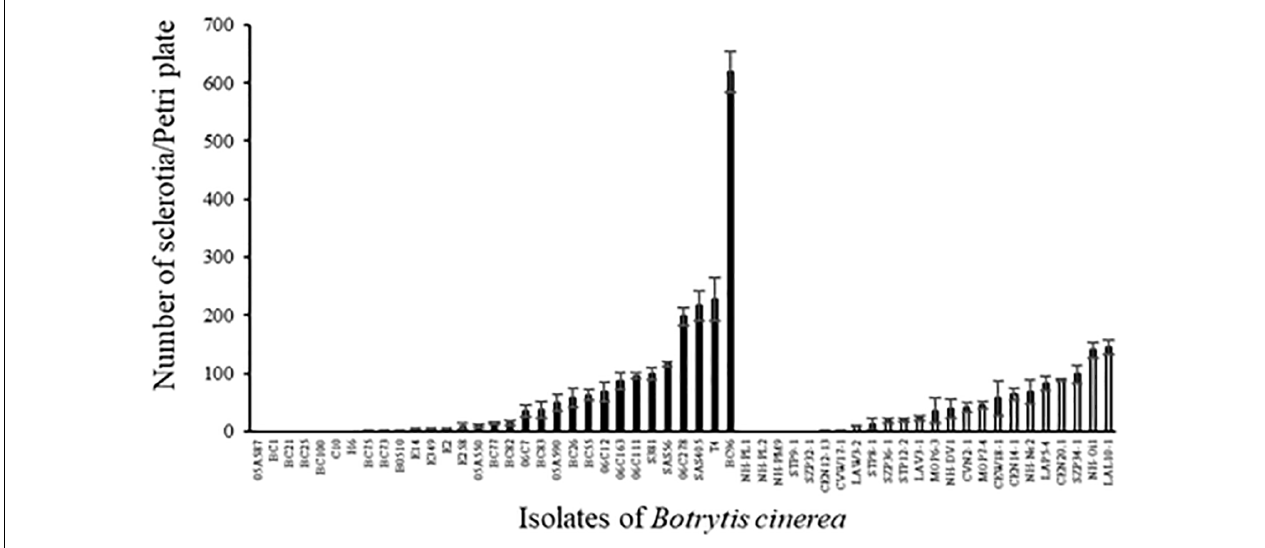
FIGURE 5 | Number of sclerotia produced by 31 agricultural (black) and 24 environmental (white) strains of B. cinerea on PDA medium after 5 weeks of incubation in controlled condition at 21 ◦ C (1 week with a photoperiod of 14 h at 114 µ mol m − 2 s − 1 and 4 weeks in the dark) and 5 weeks of incubation at 4 ◦ C in the dark. Each value represents the mean of three replicates. The vertical bar associated to each histogram correspond to SE.